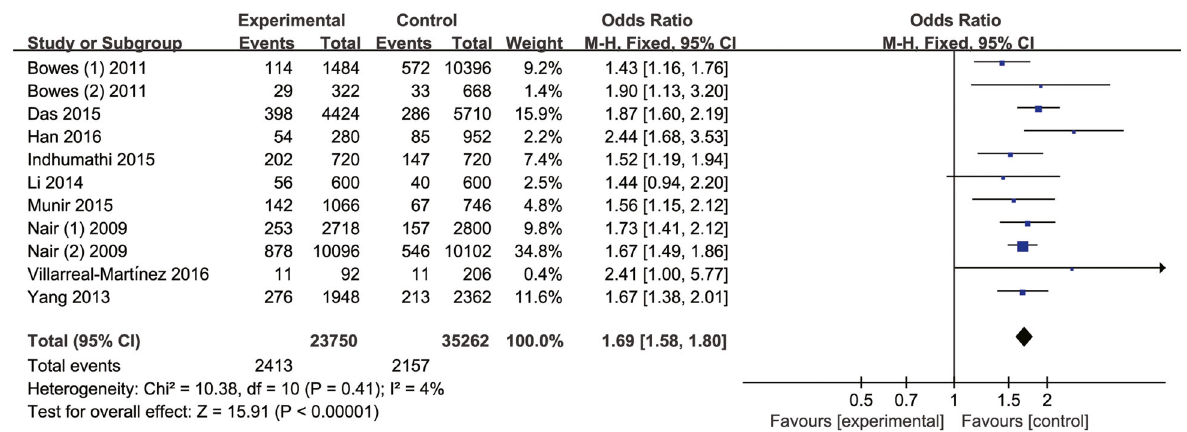
Fig. 4 Forest plot of rs17728338 in TNIP1 gene and risk of